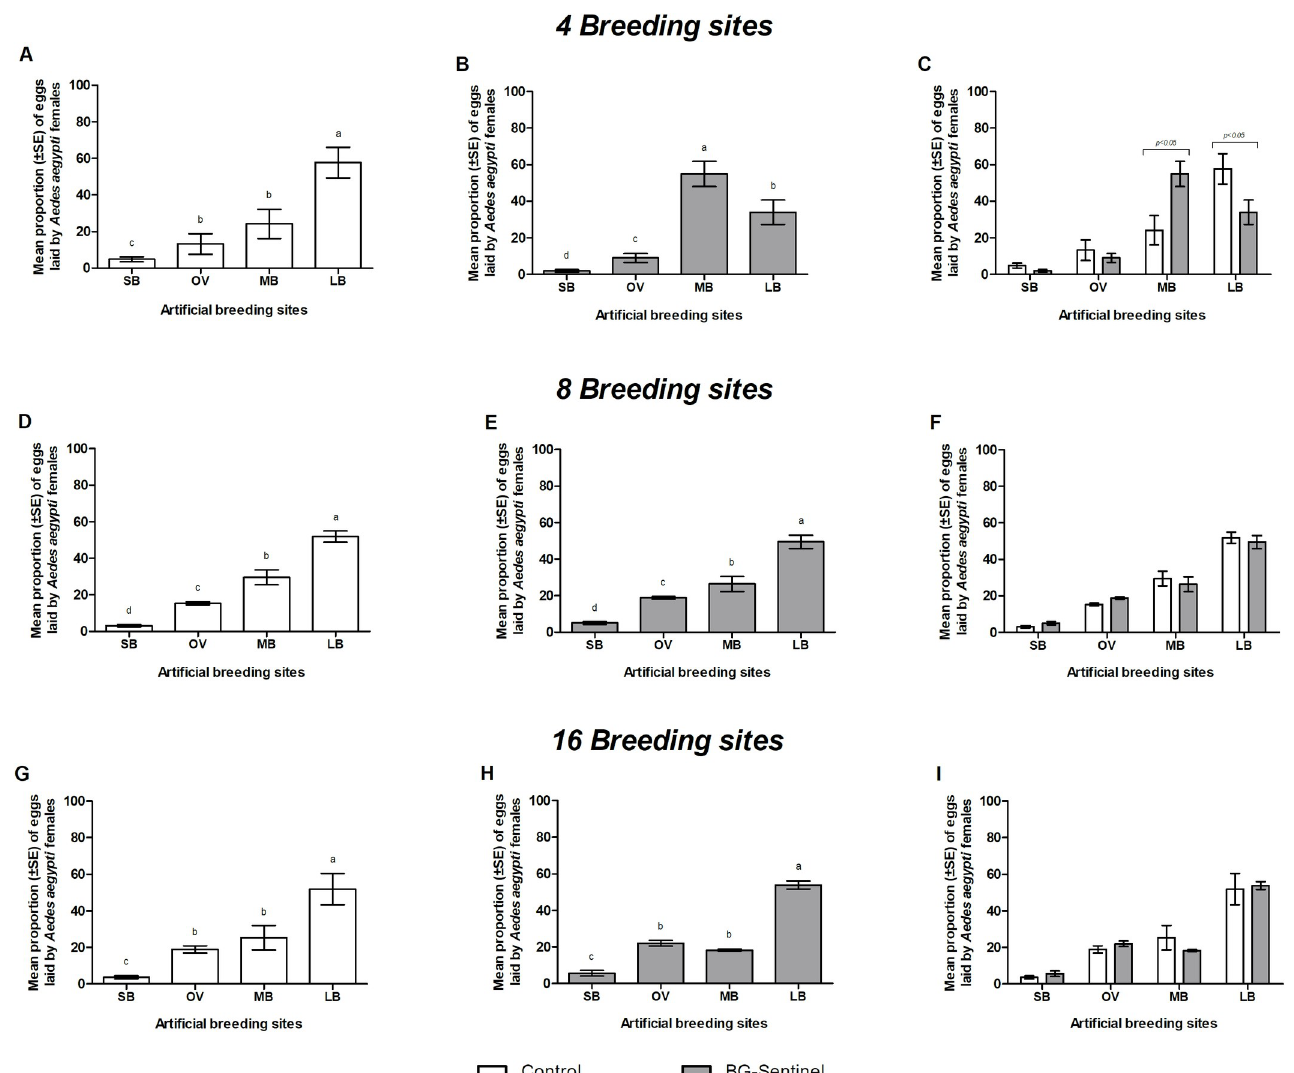
Fig 4. Mean percentage ( ± SE) of eggs laid by Aedes aegypti females in breeding sites with different sizes in simulated outdoor environments with 4, 8 or 16 breeding sites and the presence (B, E and H) or absence (A, D and G) of a BG-Sentinel trap (BGS). Panel C, F and I shows the comparison for percentages of eggs laid in different breeding sites with and without a trap. SB: small artificial breeding site (6.5 x 9 cm); OV: regular size ovitrap (9 x 12.5 cm); MB: medium artificial breeding site (20.5 x 20 cm); LB: large artificial breeding site (28 x 26 cm). Different letters on top of the bars for panels A-B, D-E and G-H indicate significant differences (p < 0.05). Horizontal lines on top of the bars in Panel C show the significant difference for MB with and without the BGS in the environment and for LB with and without the BGS trap.